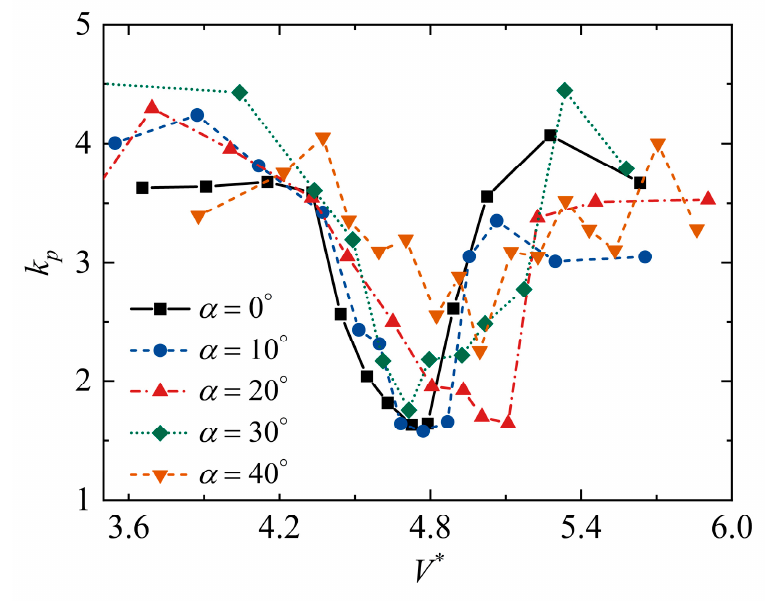
Figure 16. The variation in k p versus V* for different α .